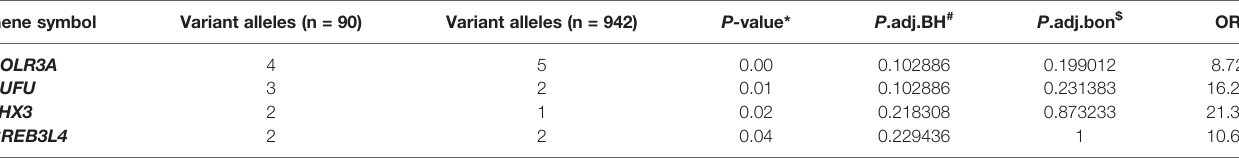
TABLE 3 | Genetic burden analysis for rare VUS in GHD cases and controls. Gene symbol Variant alleles (n = 90) Variant alleles (n =